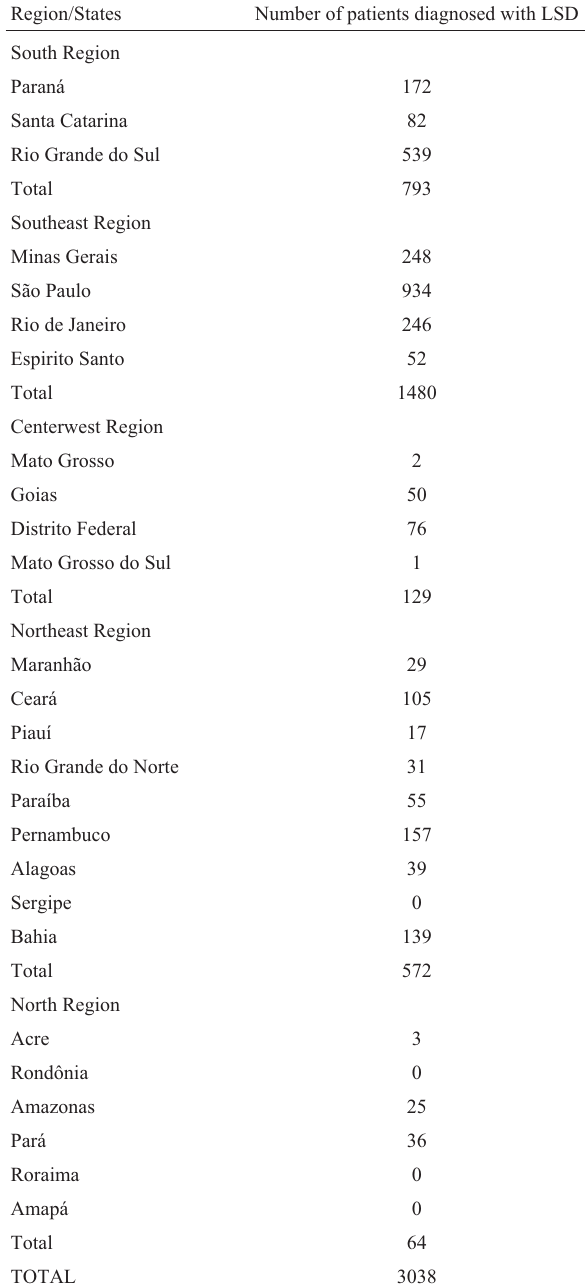
Table 2 - Number of cases diagnosed from each Brazilian state, consider- ing the 3,038 patients for whom this information was available. Region/States